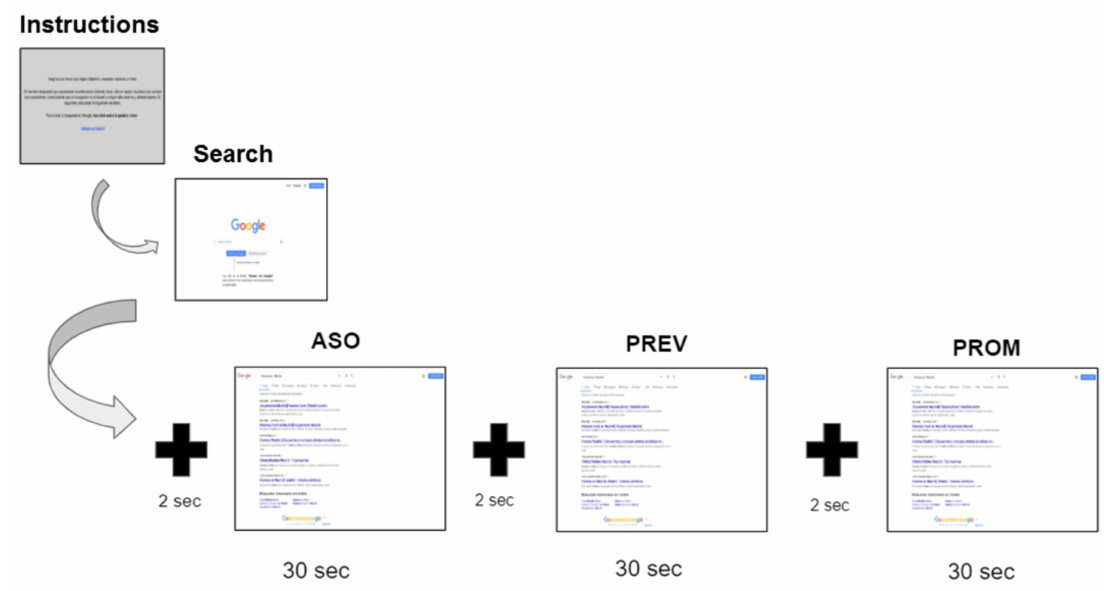
Figure 4. Experimental